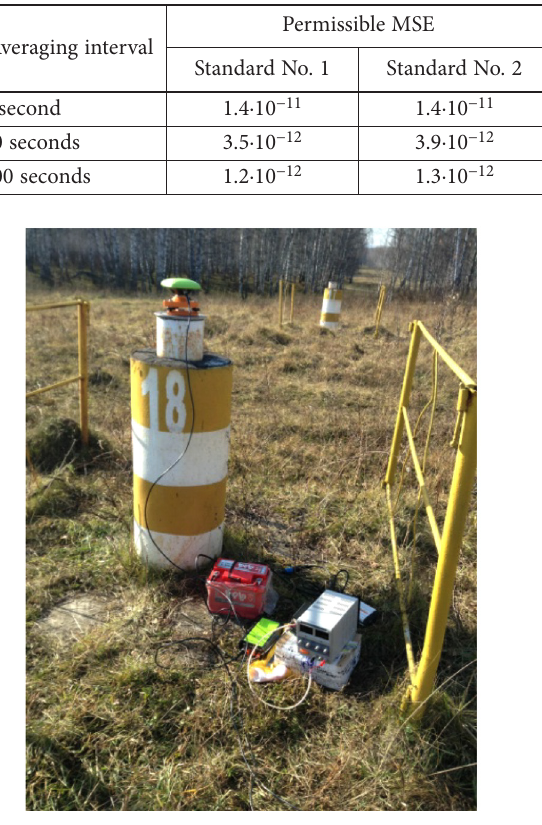
Figure 2. Geometry of O. P. Suchkov SSB in the plane of normal section passing through the line BI10–BI18